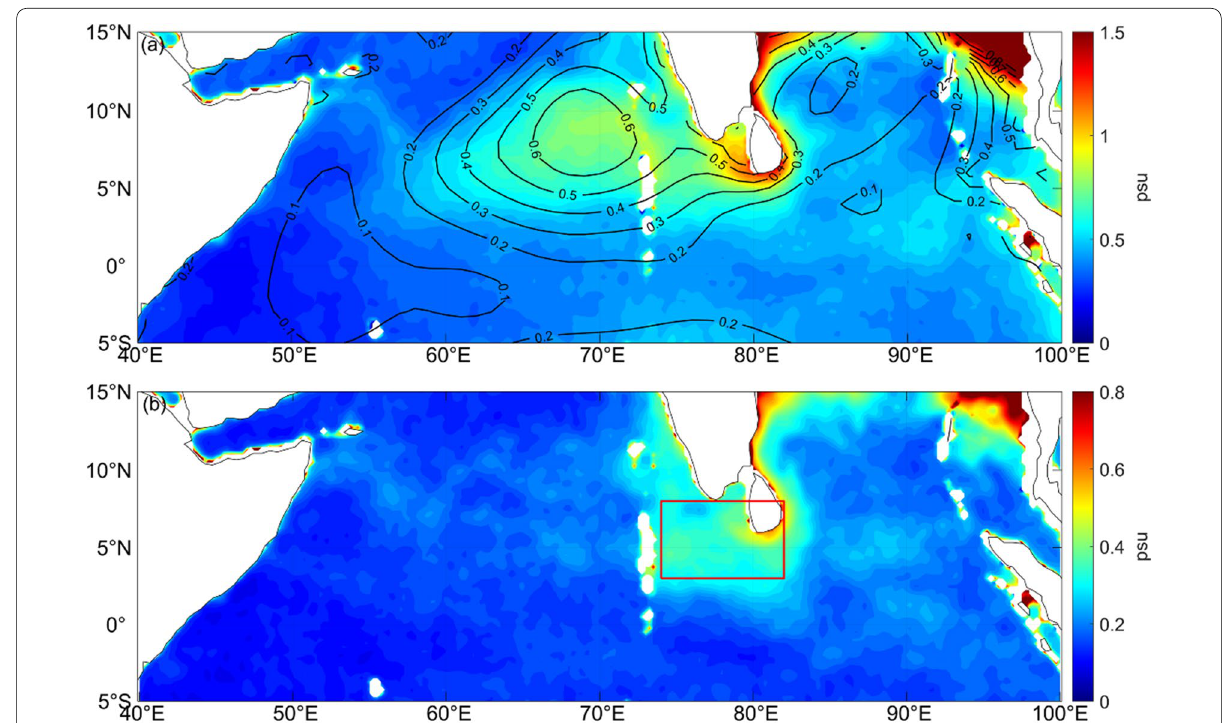
Fig. 2 Root Mean Square of SSS (unit: psu) in the central and southern North Indian Ocean. a daily SMAP SSS (shading) and climatological WOA18 SSS (contour); b SMAP SSS filtered with a 30–120-day bandpass filter. The red box (74–82°E, 3–8°N) in b indicates the study area for Fig.